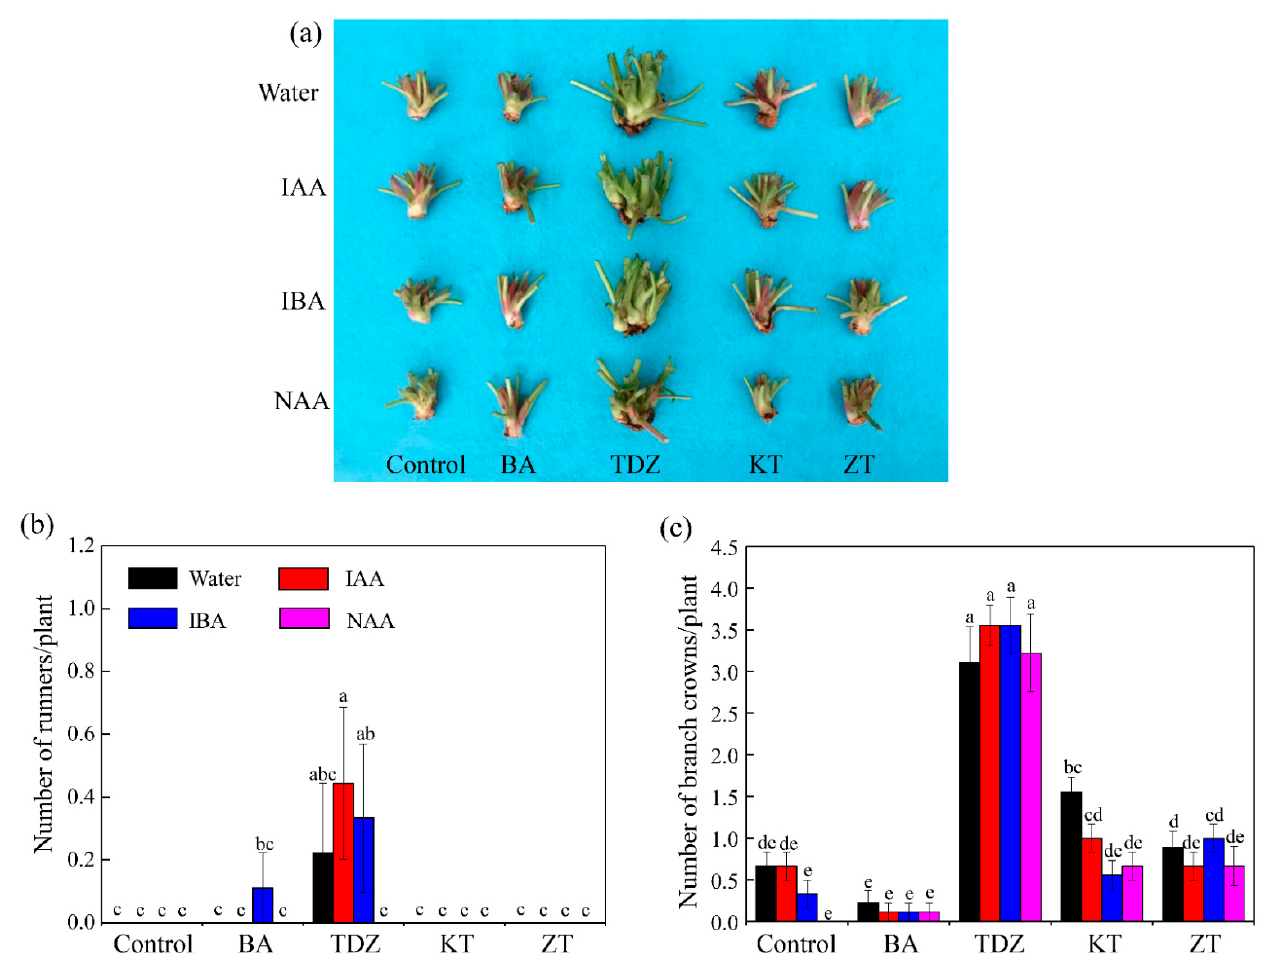
Figure 1. The effect of cytokinin and auxin on the morphology of the crown ( a ), and on the number of runners ( b ) and branch crowns ( c ) per plant in strawberry. Lowercase letters indicate significant differences calculated by Duncan’s multiple range test at p ≤ 0.05. Vertical bars indicate the standard error ( n = 3). Table 2. The effect of cytokinin and auxin on the growth of strawberry plants.